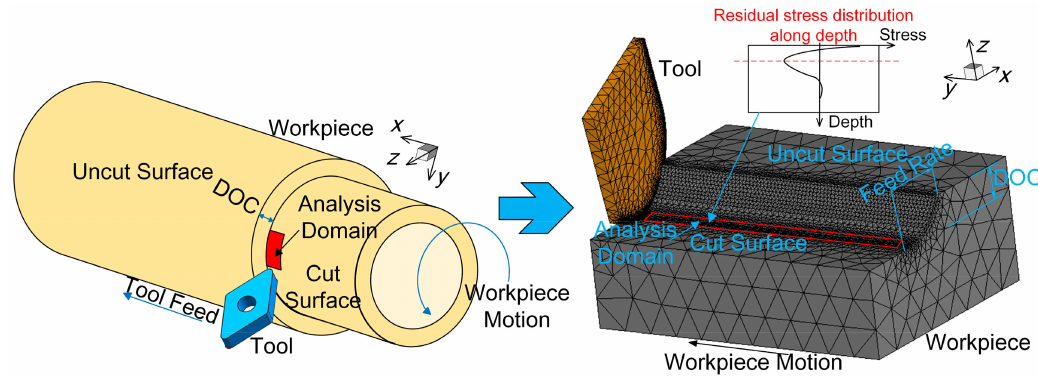
Figure 2. The modeling simplification of the cylindrical